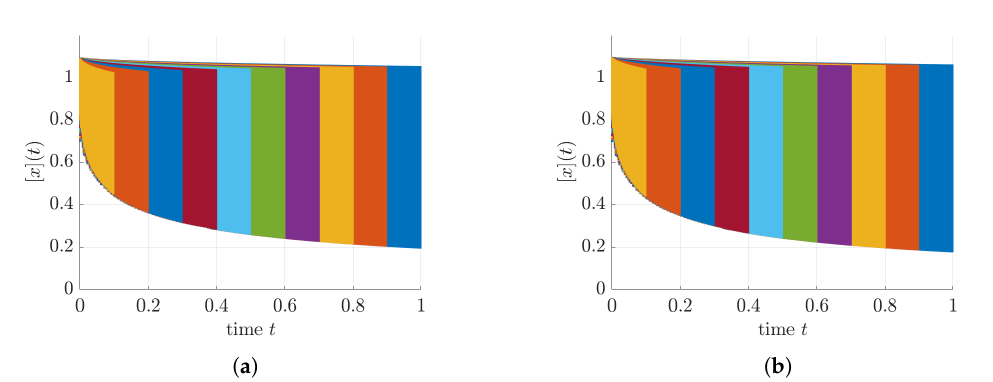
Figure 5. Simulation of the system model (40) with (41) using Theorem 3: ( a ) Simulation for ν = 0.5; ( b ) Simulation for ν ∈ [ 0.5 ; 0.6 ] .